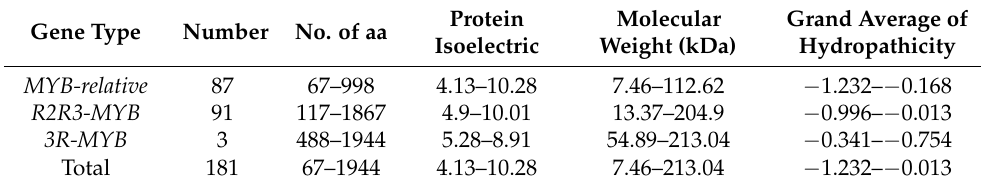
Table 1. Classification and physicochemical properties of identified AcMYB TFs in kiwifruit. Gene